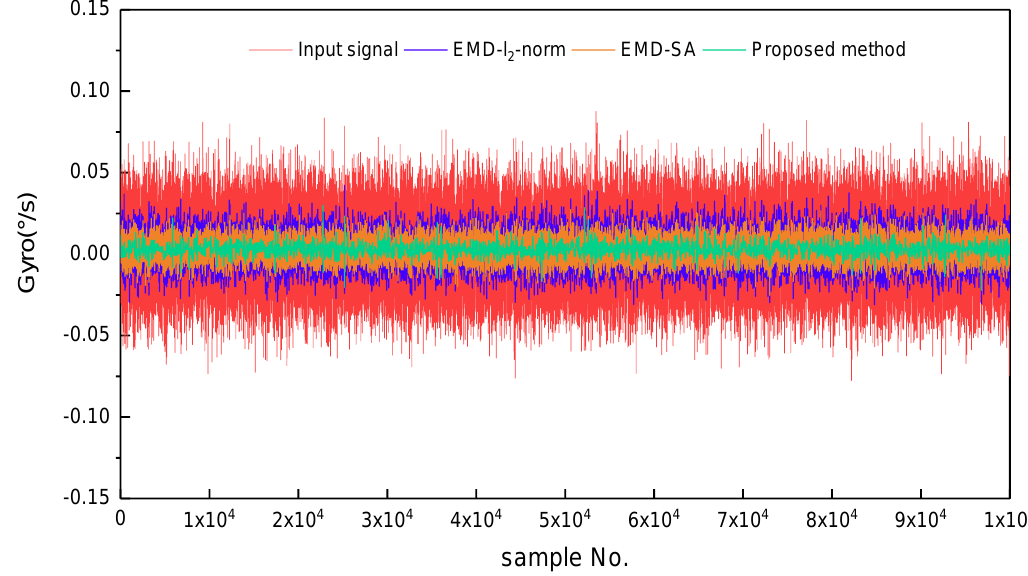
Figure 6. Gyroscope signal and its denoised results for three denoising methods. The red line is the gyroscope signal; the blue, orange, and green lines are the denoising results of Euclidean norm measure method (EMD- 𝑙 2 -norm), the sliding average filtering method (EMD-SA), and the proposed method, respectively.